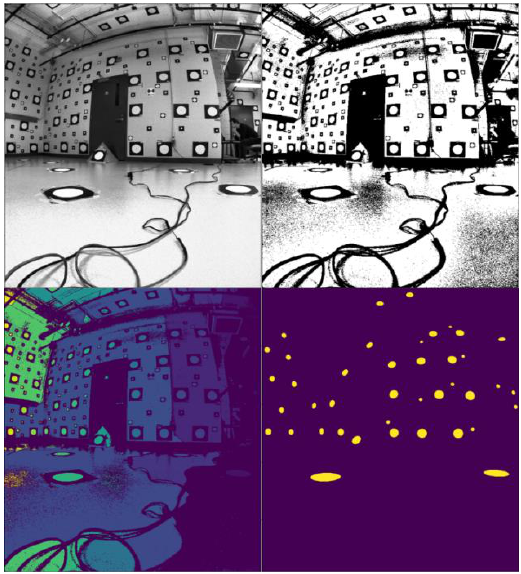
Figure 1a) Top left, original image. 1b) Top right, binary image